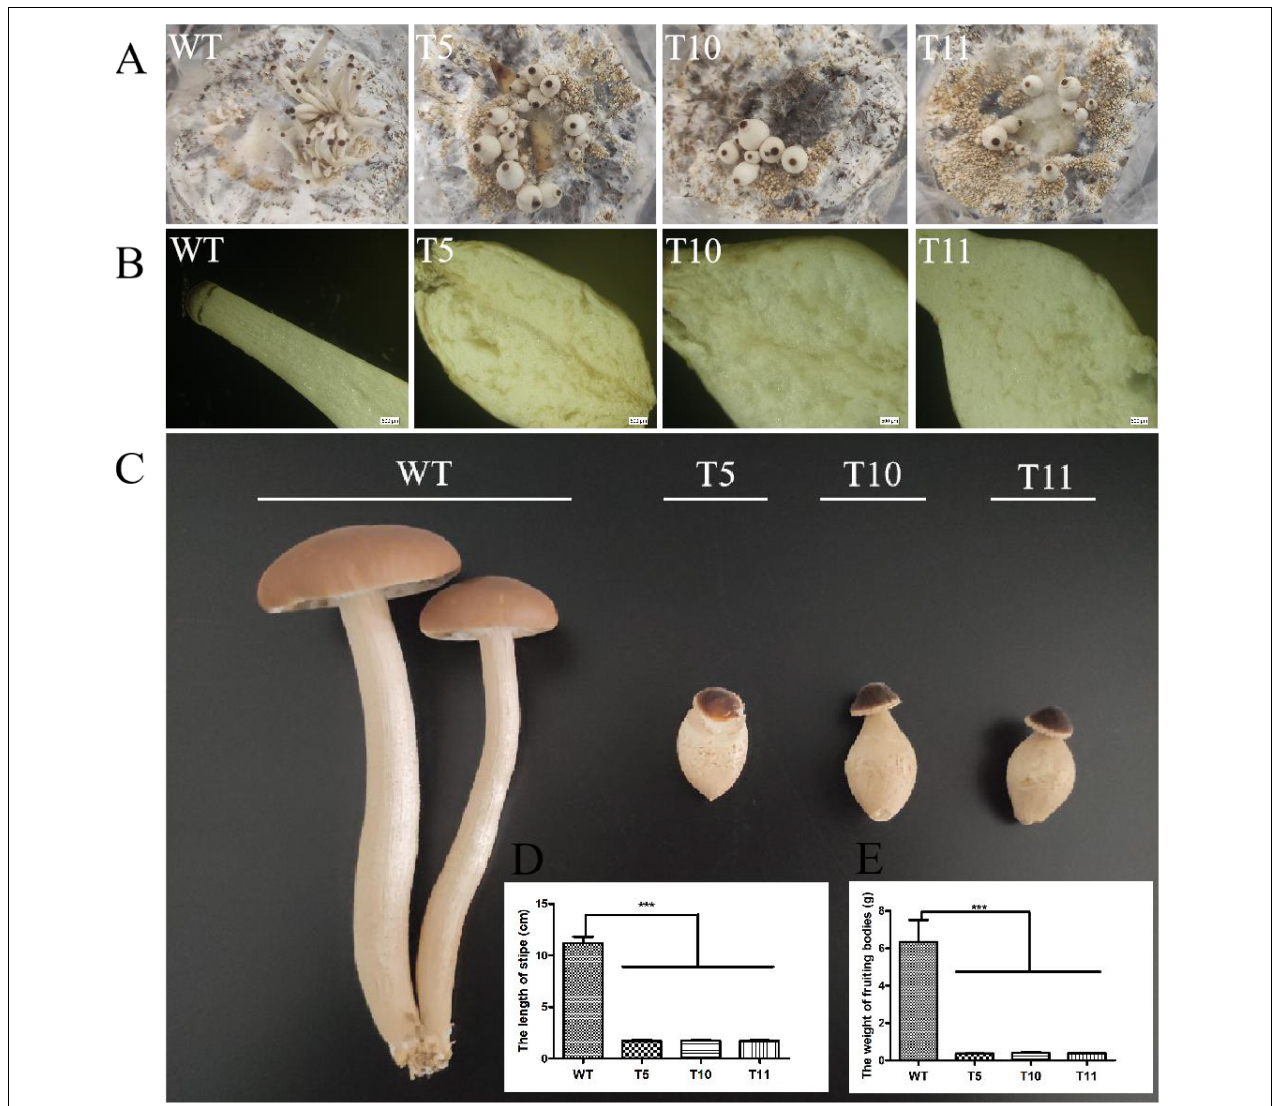
FIGURE 4 | Morphology of the fruiting bodies in WT, T5, T10, and T11. (A) Young fruiting bodies. (B) Longitudinal section image of stipes. Bar, 500 µ m. (C) Mature fruiting bodies. (D) The length of stipes. (E) The weight of fruiting bodies. Asterisks (***) indicate the data that differed significantly based on p < 0.0001 ( t -test) as the significance